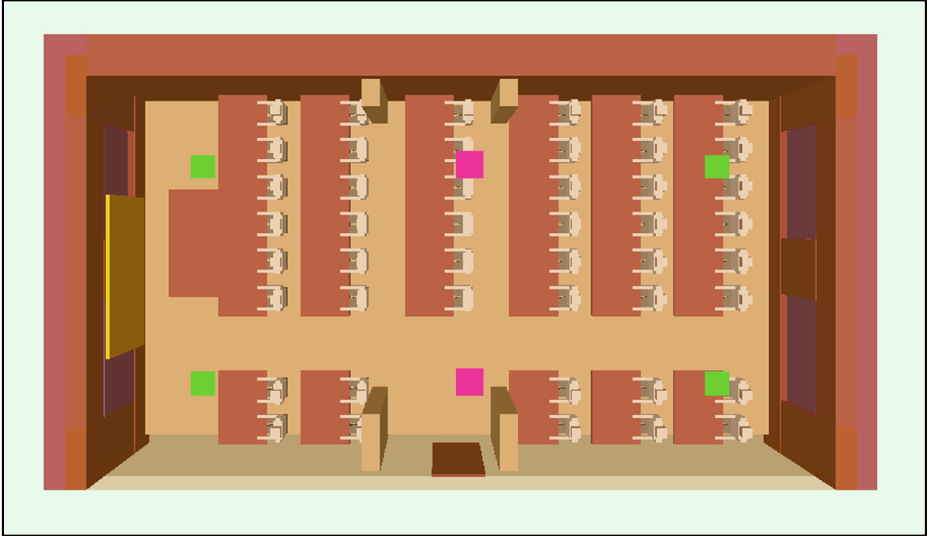
Figure 5. Visualized digital model: full room and the mechanical air conditioning system (green—air diffusers in the ceiling, pink—air uptake inlets in the ceiling).